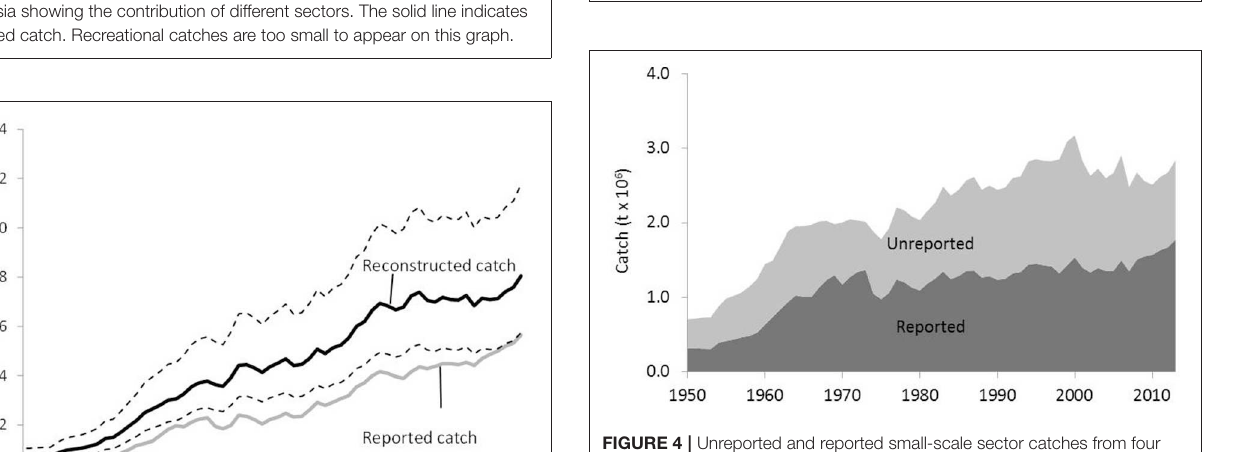
FIGURE 4 | Unreported and reported small-scale sector catches from four Southeast Asian countries.